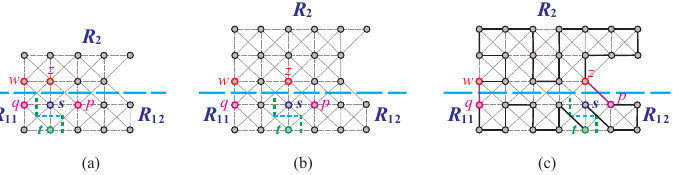
Figure 18. ( a , b ) A vertical and horizontal separation on R 1 under that s , t ∈ R 1 and { s , t } is a vertex cut of R 1 , and ( c ) a Hamiltonian ( s , t ) -path in C ( m , n ; k , l ; c , d ) . Case 2: s , t ∈ R 2 . A Hamiltonian ( s , t ) -path of ( C ( m , n ; k , l ; c , d ) can be